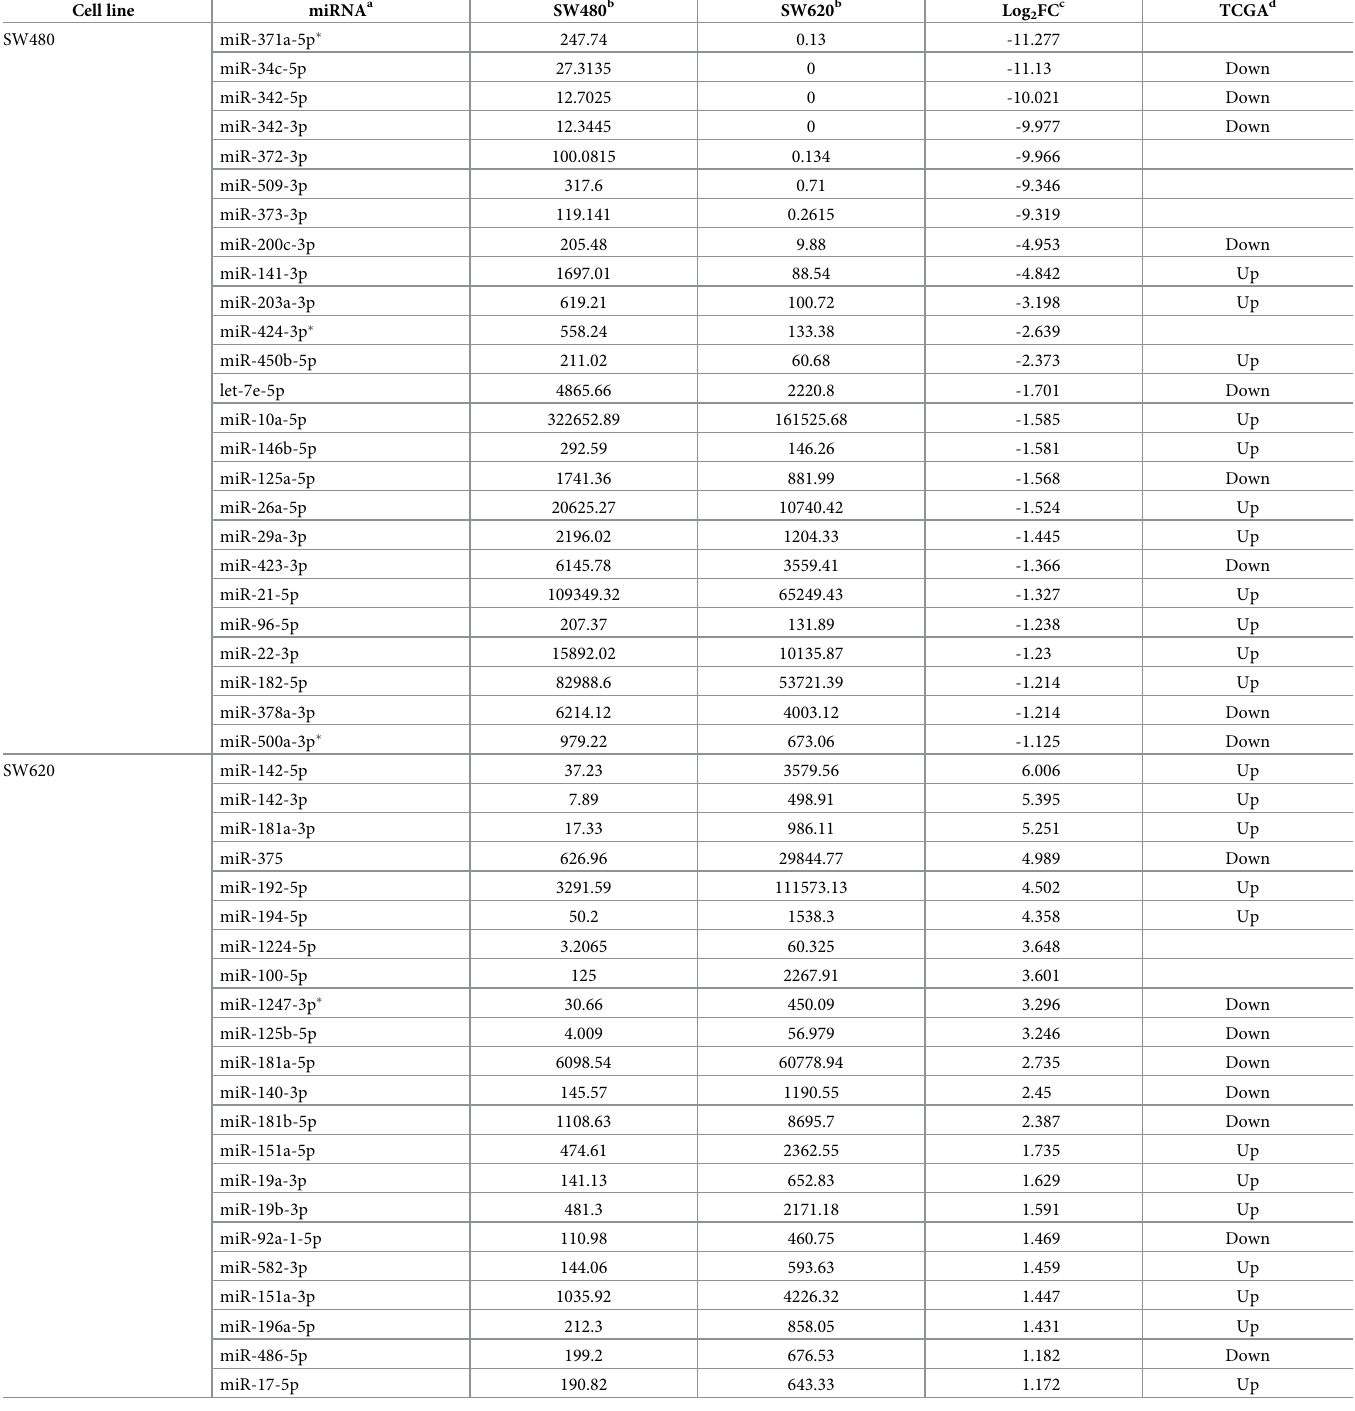
Table 1. Selected miRNAs highly expressed in SW480/SW620 cell lines. Cell